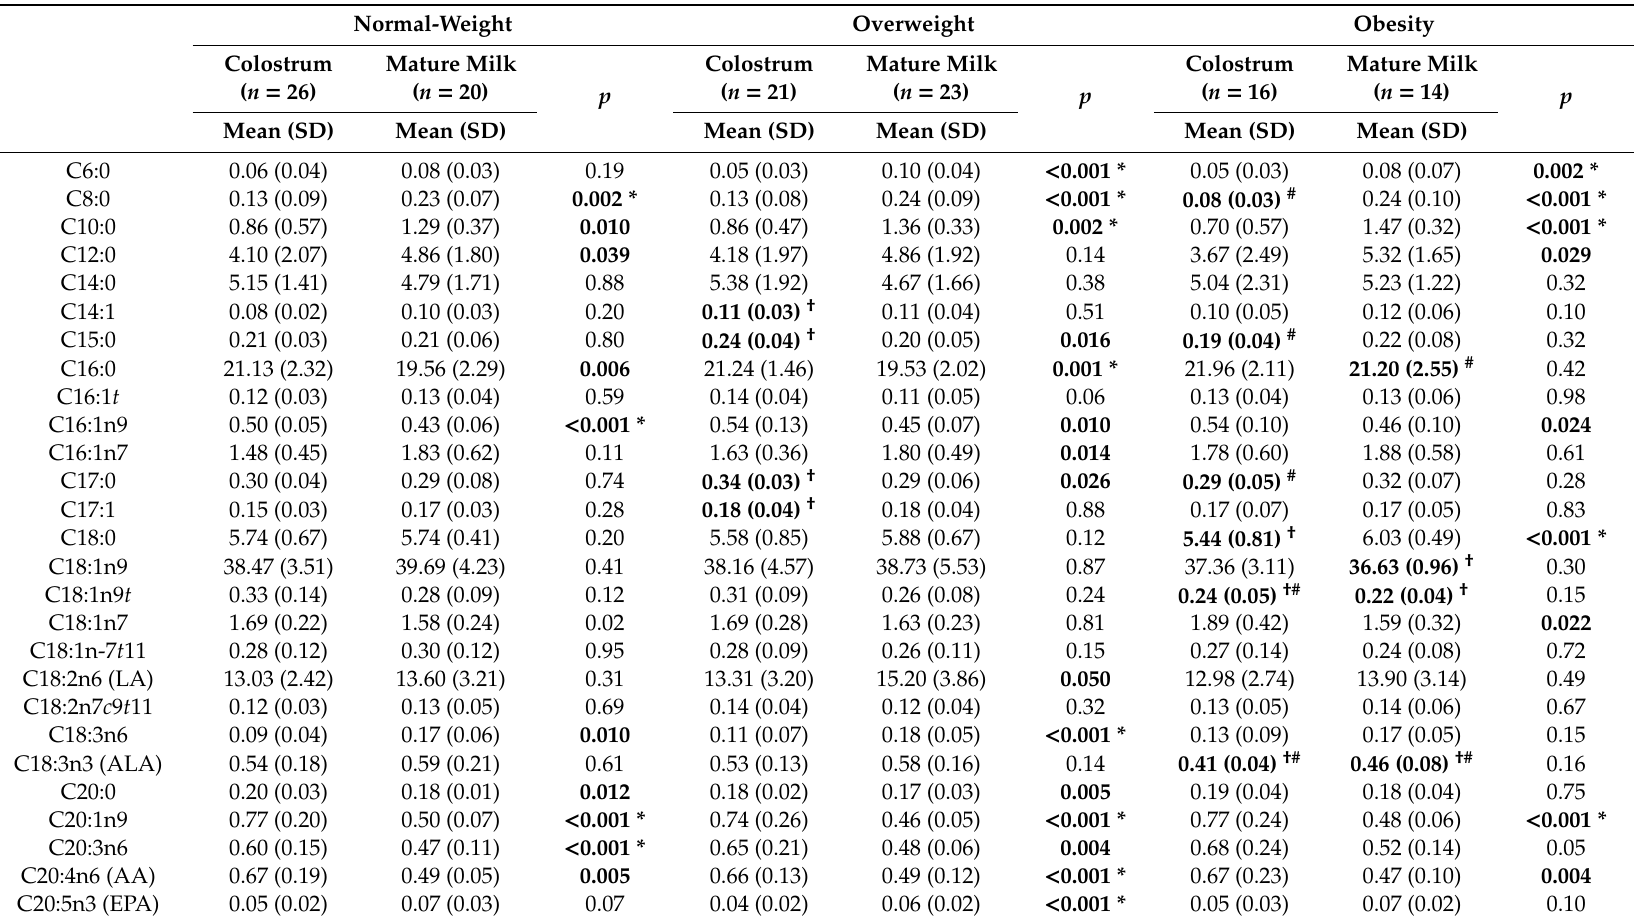
Table 2. Human milk fatty acids profile according to maternal pre-pregnancy